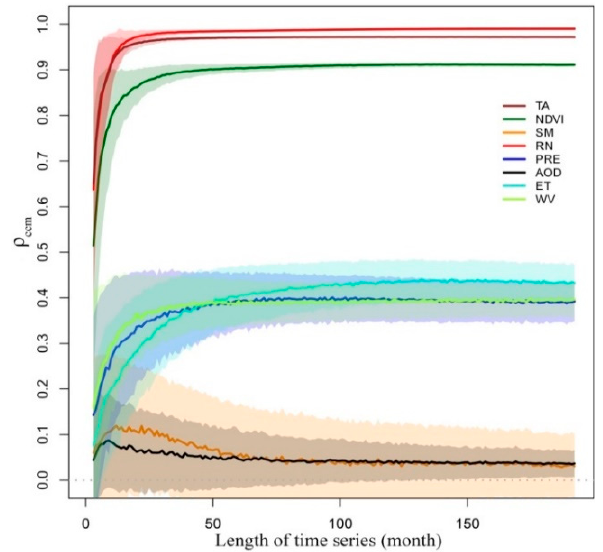
Figure 3. Causality detection between LST and environmental factors for the pixel selected from PMC region based on the CCM method. The solid line in the figure shows the curve of the mean value of ρ ccm with the length of the time series (month). The shaded upper and lower ends indicate the range of ρ ccm ± SD (standard